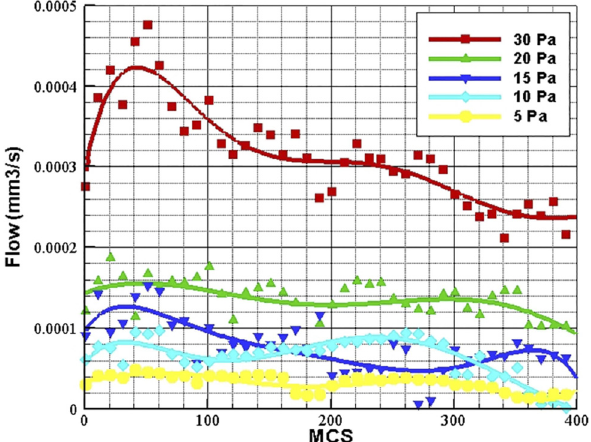
Fig 15. Flow variations in different values of pressure difference during loop elongation. The flow data is averaged over 10 independent simulations.